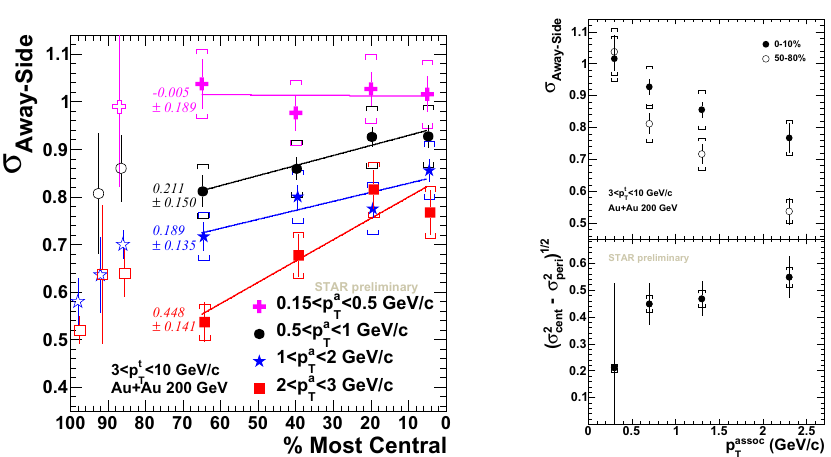
Figure 5. (left) Away-side dihadron correlation peak width as a function of centrality for various associated particle p T ranges. (right) Away-side peak width in peripheral and central collisions (upper) and the quadratic di ff erence of the widths (lower) as a function of associated particle p T